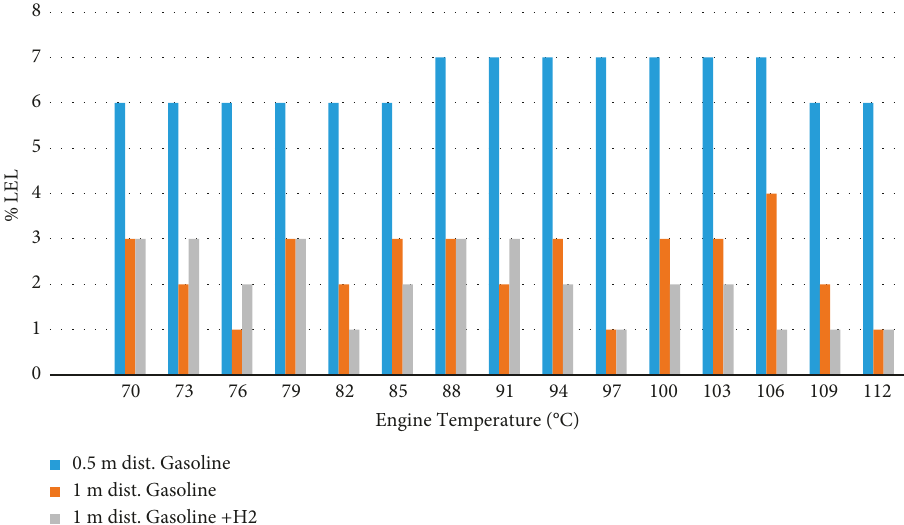
Figure 4: LEL exposure at 0.5m and 1m distances at 3000rpm engine speed.